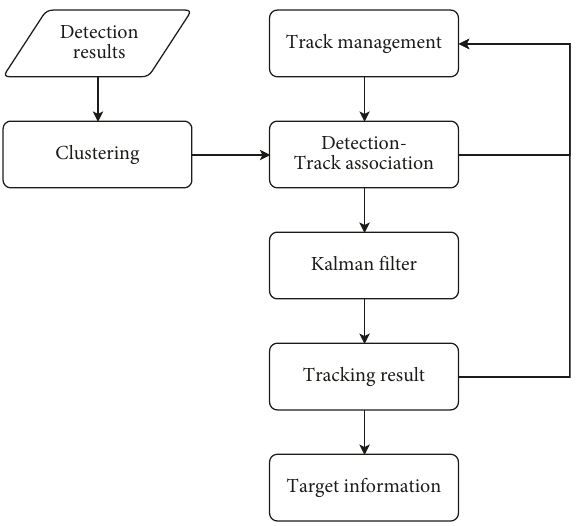
Figure 2: FMCW radar signal processing